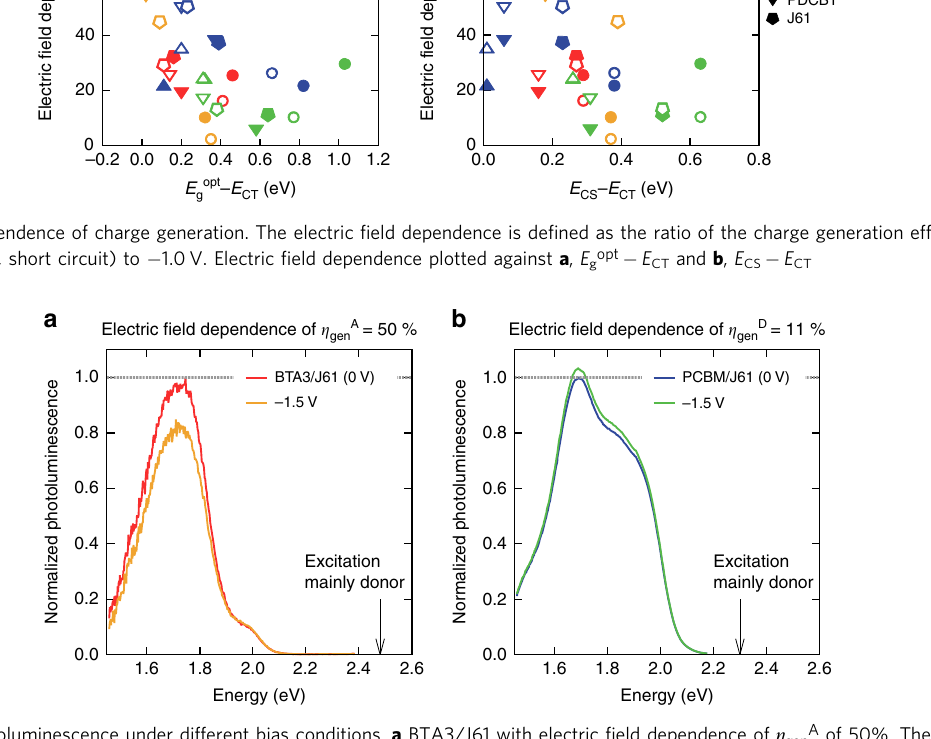
Fig. 6 Normalized photoluminescence under different bias conditions. a BTA3/J61 with electric fi eld dependence of η gen A of 50%. The excitation wavelength of 500 nm is indicated by the arrow. b PCBM/J61 with electric fi eld dependence of η gen D of 11%. The excitation wavelength of 540 nm is indicated by the arrow. The spectra are normalized by the spectrum measured under an applied bias of 0 V. The decrease of the PL intensity for BTA3/J61 ( a ) with − 1.5 V bias indicates that emission from the S 1 state decreased with increasing internal electric fi eld. The PL spectra of the pristine fi lms are shown in Supplementary Fig.